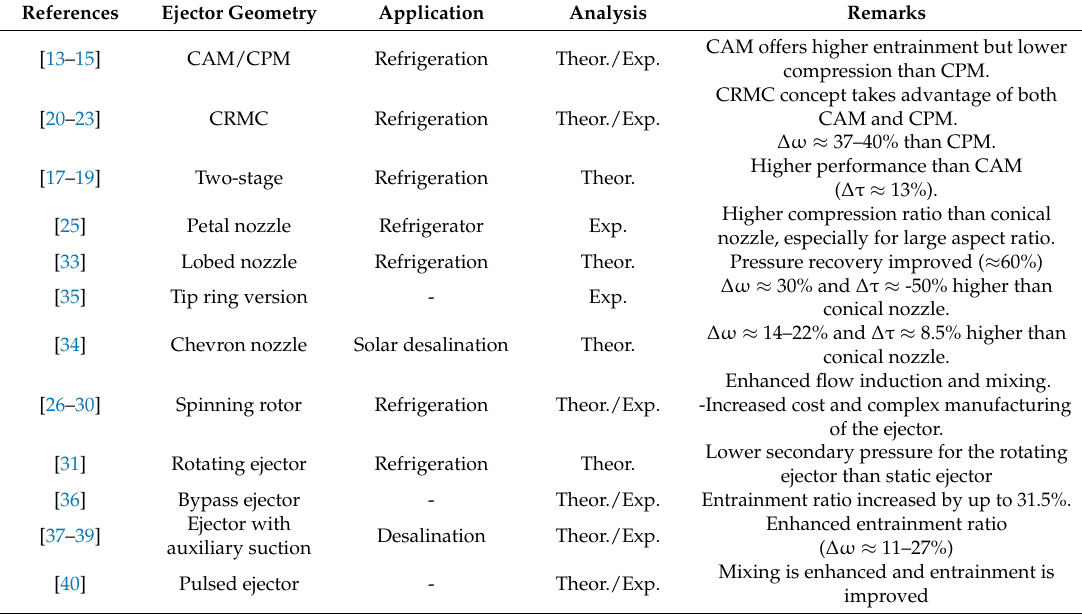
Table 1. Variants of ejector